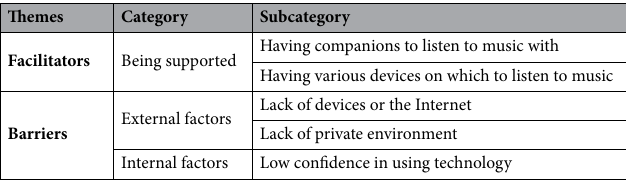
Table 7. Facilitators and barriers to implementing music